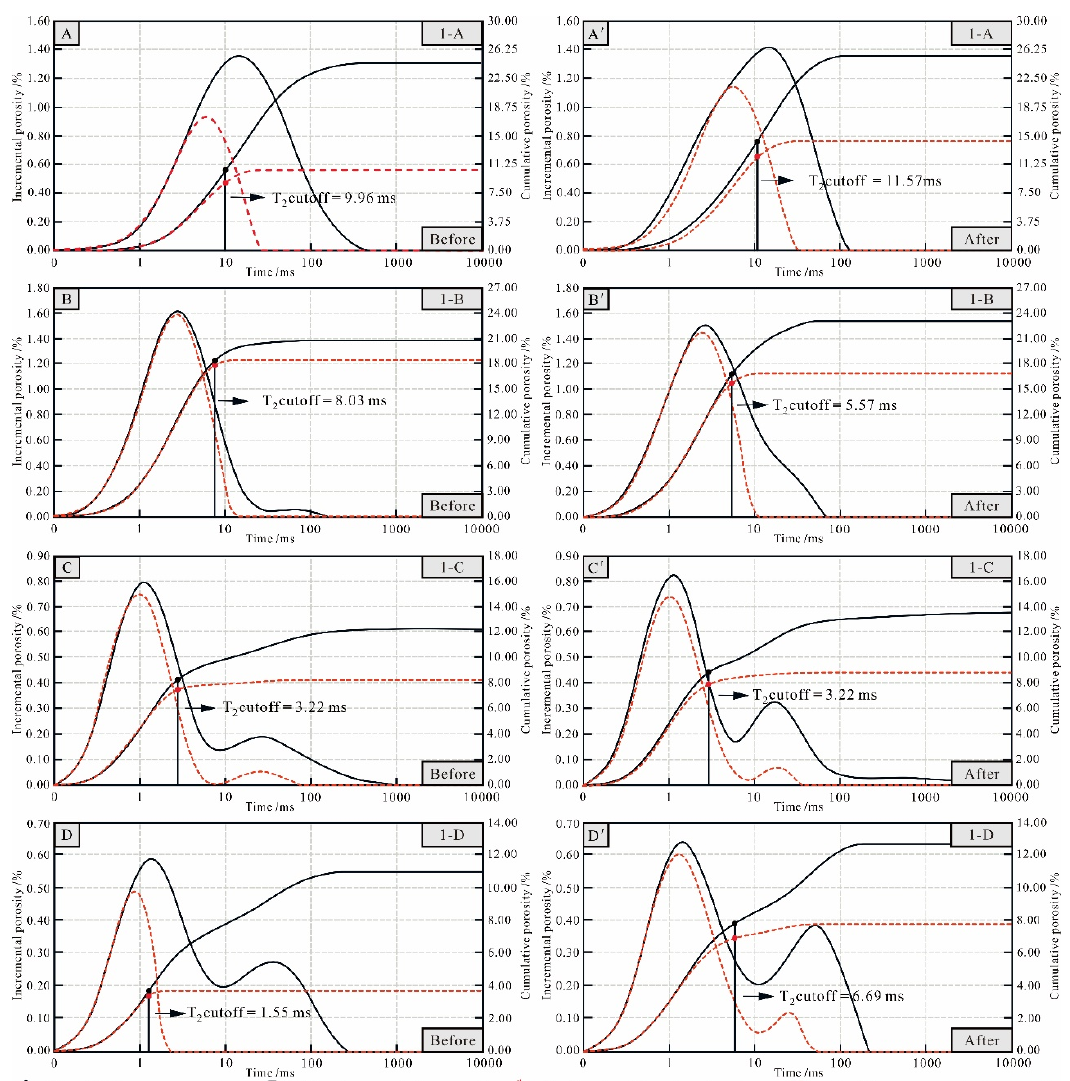
Figure 7. Nuclear magnetic resonance T 2 spectrum distribution of the selected mixed carbonate-siliciclastic rocks. ( A – D ): Table 1. spectrum distribution before acidification; ( A’ – D’ ): T 2 spectrum distribution after acidification.